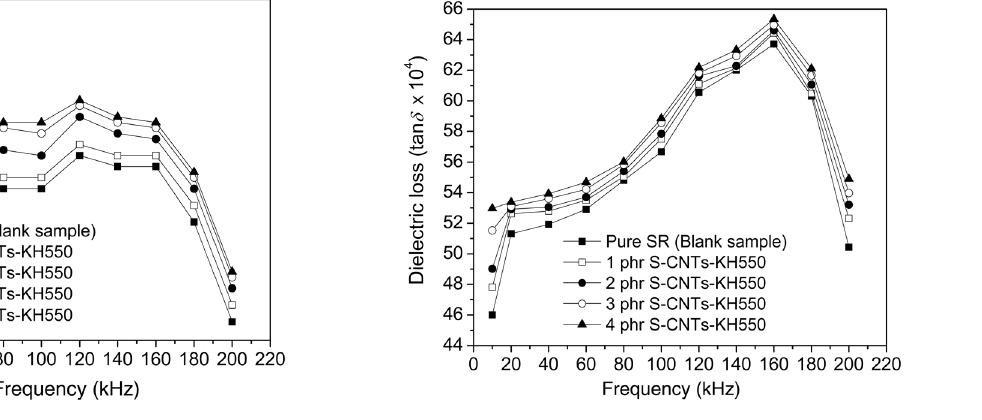
Figure 6 Relative dielectric permittivity of L-CNT-KH550/SE com- posites with different frequencies of outer electric field.